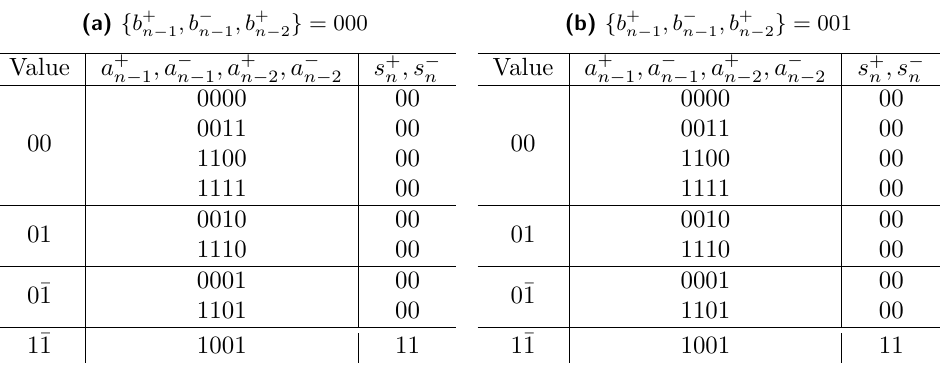
Table 2: The possible bits for s +